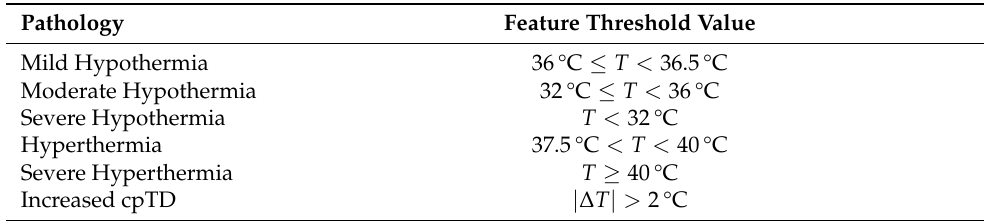
Table 1. Simulated temperature-dependent